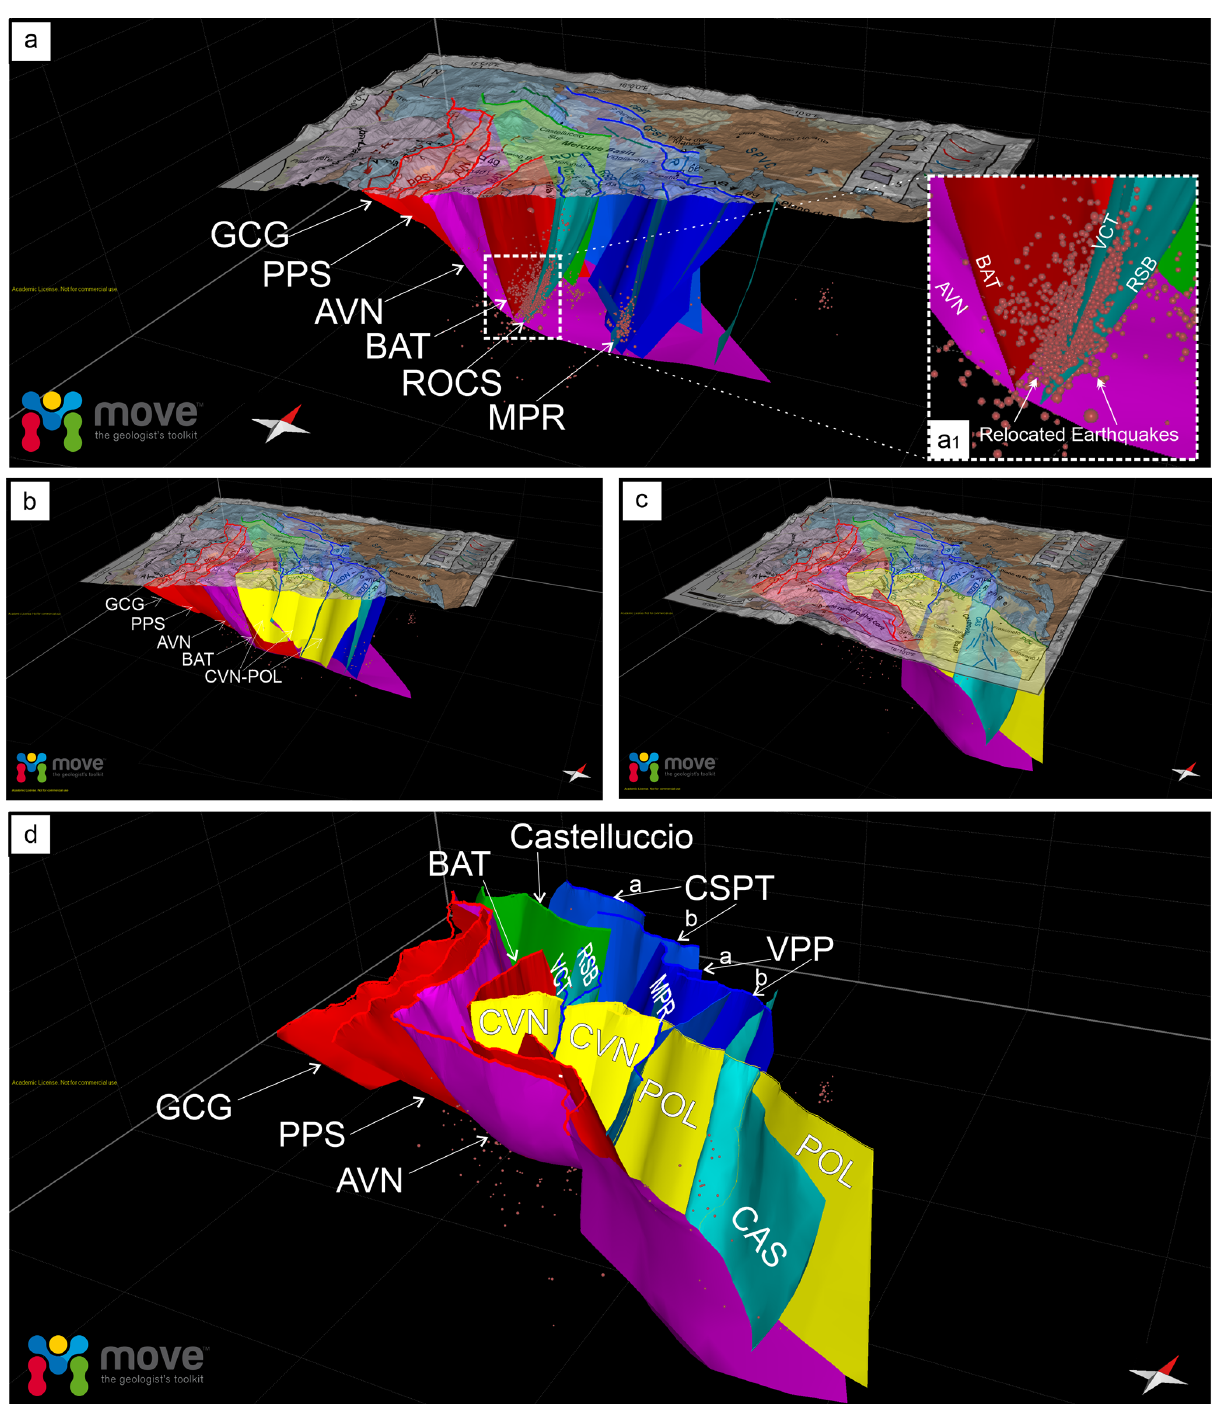
Figure 8. 3D fault model of the extensional system at the Calabrian–Lucanian boundary extrapolated down to ∼ 10–12km. In panels (a, b, c) the geological–structural map (from Brozzetti et al., 2017a) is superimposed over a 10m resolution DEM (from Tarquini et al., 2012). The reconstruction of the fault systems is discussed in the paper. In (a) , the lower right inset (a1) shows the detail of the main faults involved during the 2010–2018 seismic activity. (d) 3DFM of all extensional fault realized through the Move software. For the acronyms, see Sect. S1. The faults belonging to the E–NE-dipping CRFS fault set are represented in red and violet, whereas the antithetic ROCS and MPR faults are shown as blue surfaces (fault acronyms as in Fig. 2). The yellow surface is the three-dimensional surface of the POL and its westernmost segment (CVN) bounding, to the north, the Campotenese